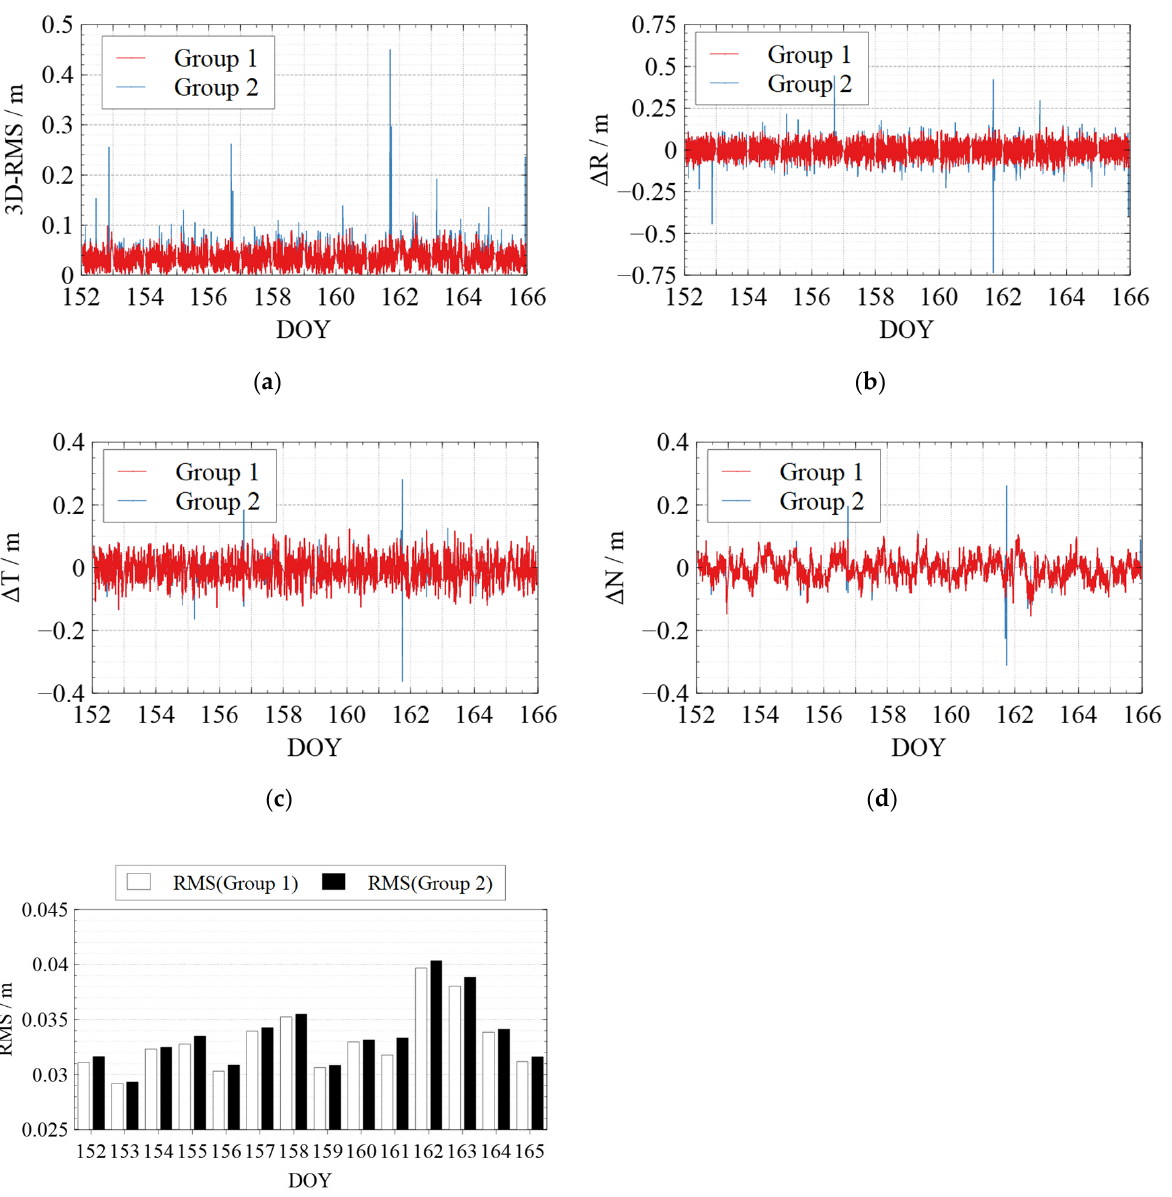
Figure 6. Comparison between the kinematic orbits of Swarm-A and the precise orbits provided by the ESA. ( a ) 3D-RMS of the comparison results; ( b ) Difference in Radial direction; ( c ) Difference in Tangent direction; ( d ) Difference in Normal direction; ( e ) Average 3D-RMS statistics of the comparison results. The red line shows the results of Group 1, while the blue line shows the results of Group 2 in ( a – d ). The white blocks and black blocks in ( e ) represent the RMS of Group 1 and Group 2 on each day, respectively.